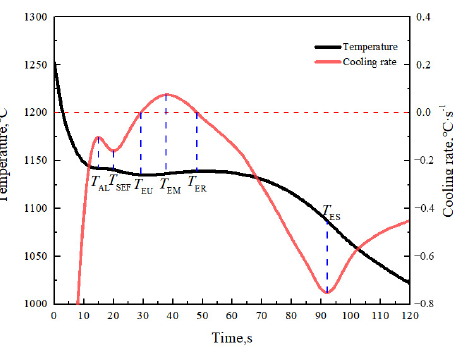
Figure 7. Typical cooling curve, cooling rate curve, and characteristic points of compacted graphite iron.